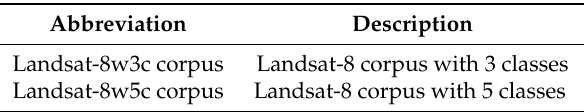
Table 1. Abbreviations on our Landsat-8